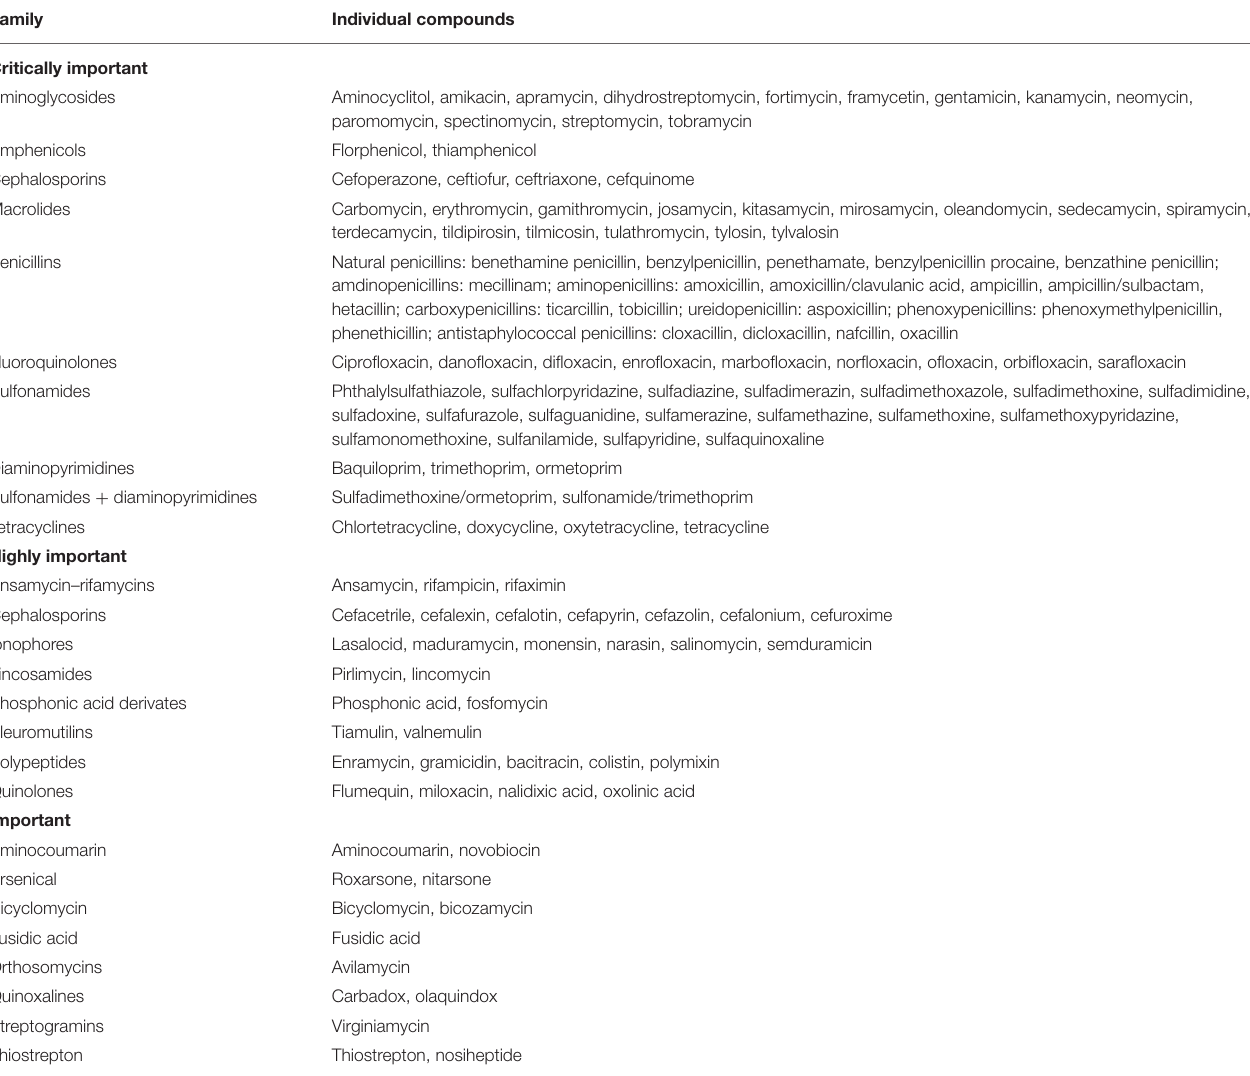
TABLE 1 | Families of antibiotics and individual compounds used as search terms.